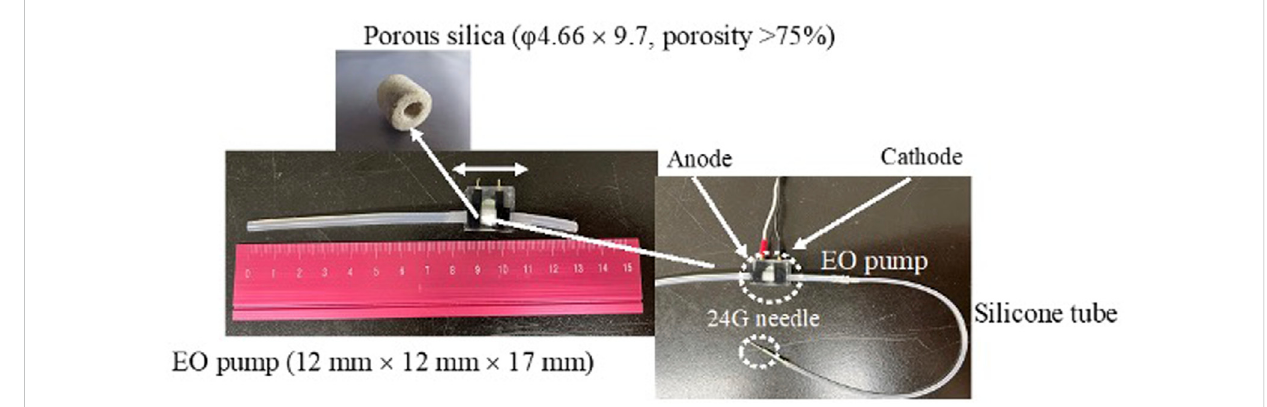
FIGURE 1 Set-up of the EO pump system and electro-osmotic fl ow in silica capillary. Filling water in a silica capillary has an electric double layer at the liquid- solidinterface.Externalapplication ofanelectricalpotentialalongthelengthofthecapillaryresultsinmotiontowardthecathode ofsomeoftheH+ions in the liquid phase of the electric double layer. As they move under the in fl uence of the applied fi eld, they draw the liquid along